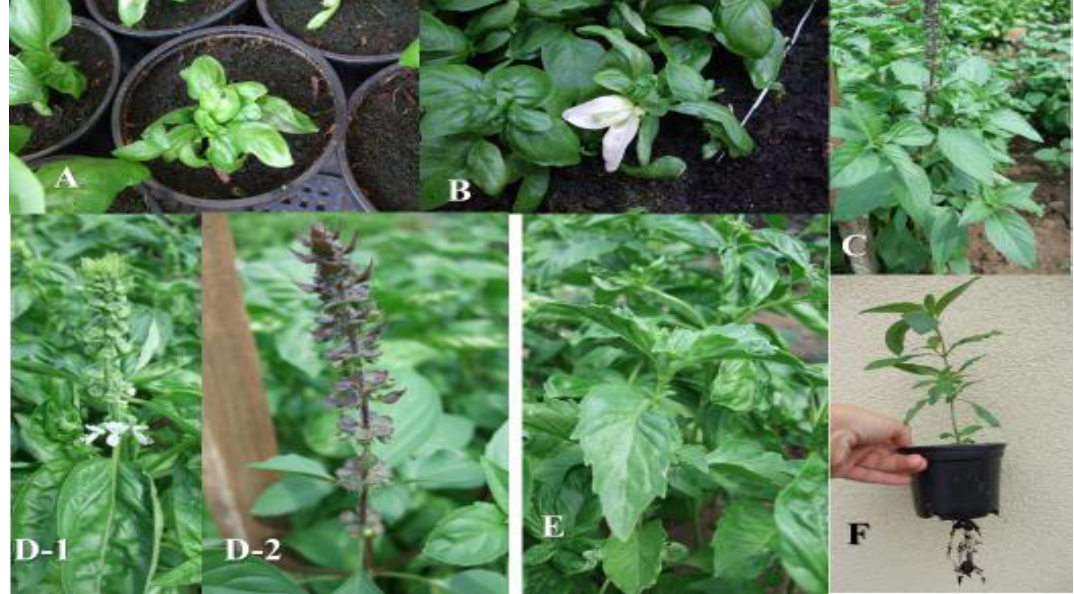
Figure 7. Post-treatment mutations A: deformed congestion, B: tissue chimeras, C: spearmint/spiky leaf shape, D: anthocyanin flowering shaft and flower scrubs (D-1 normal, D-2 mutant 30GY A7), E- spearmint/spiky leaf shape with split/toothy edges, F: spearmint leaf shape